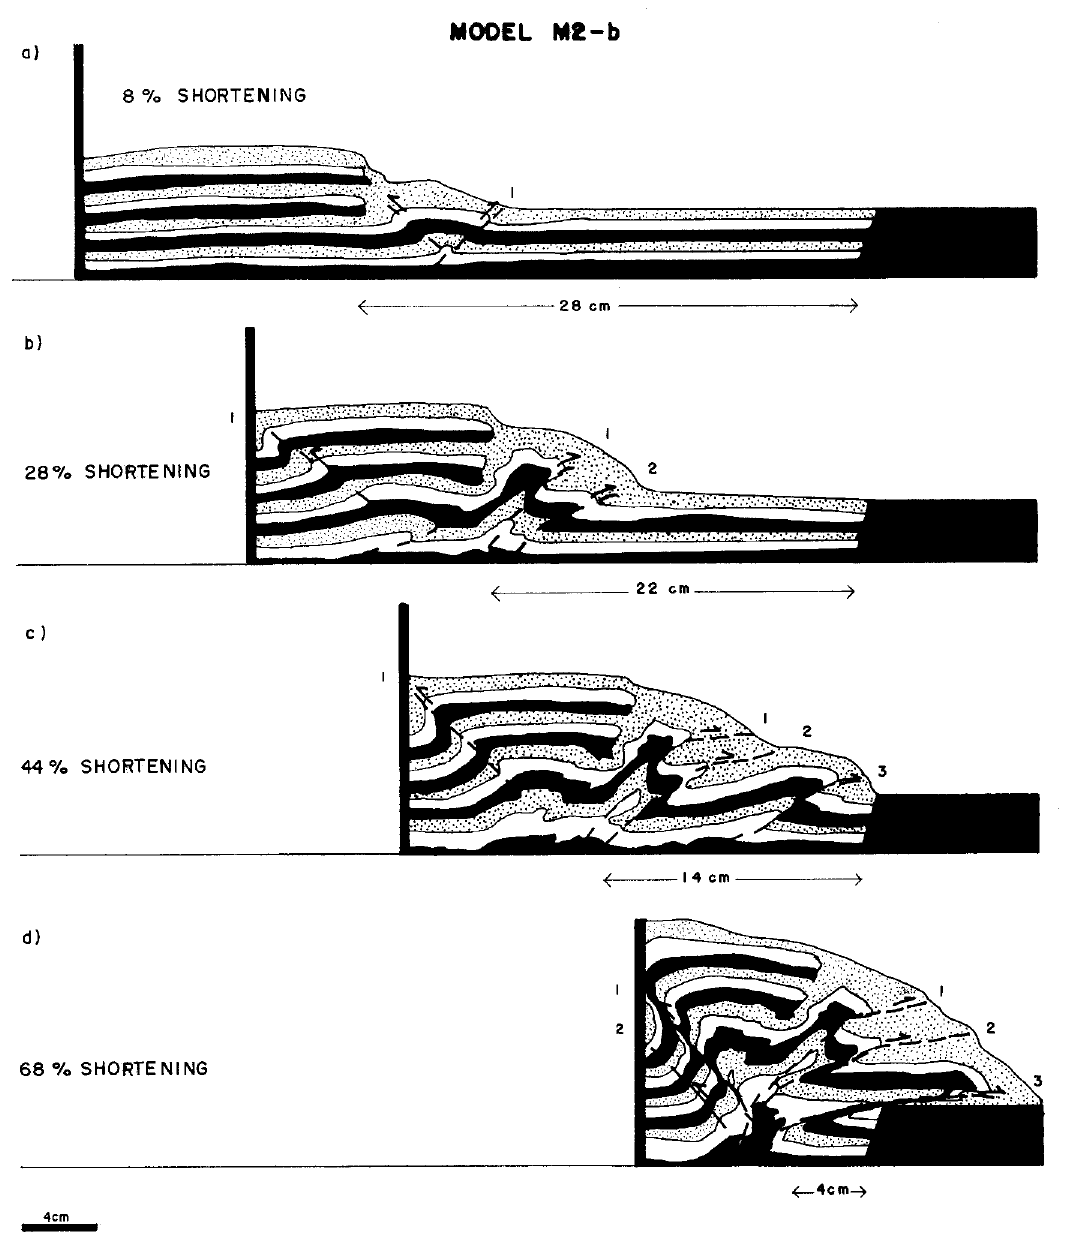
Fig. 10 – Successive stages of model M2-b (small obstacle and deformable backstop). Model M2-b presents the same geometry as models M1-b and M2-a, after (a) 8%; (b) 28%; (c) 44%; (d) 68% shortening (sideview). Note the difference in the thrust geometry between Figs. 9d and 10d. Photographs in Figs. 5b, c also illustrate stage (d) of the present model in two more sections.